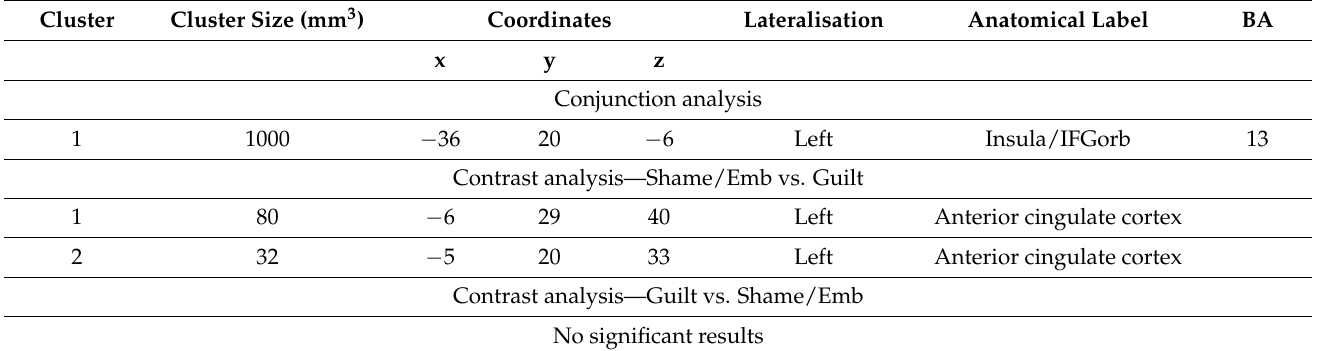
Table 5. Contrast analyses